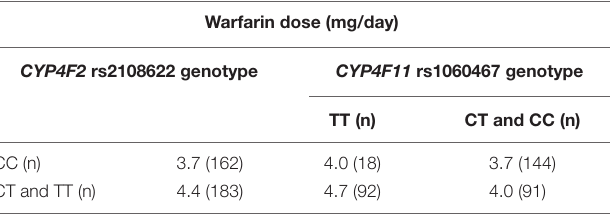
TABLE 5 | Relationship between CYP4F2 and CYP4F11 SNPs and stable warfarin dose requirement ∗